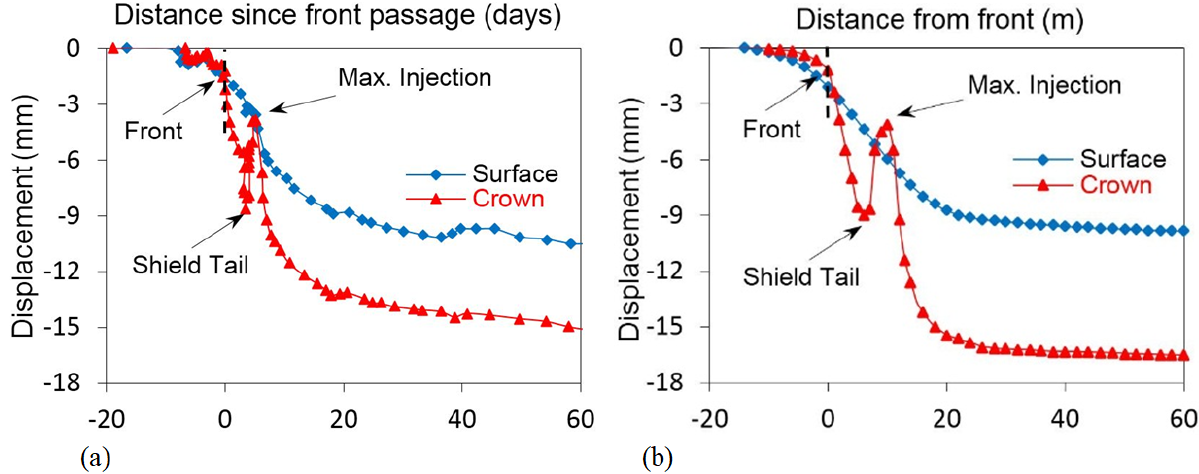
Figure 14 Longitudinal ground settlements: (a) field data and (b)